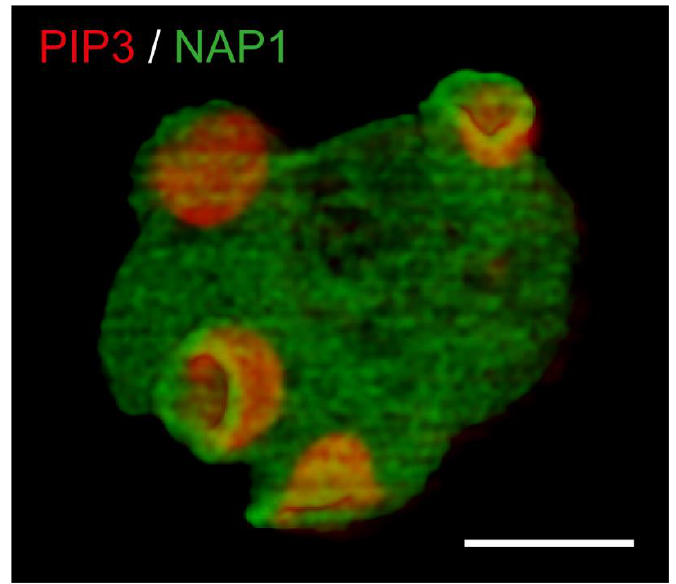
Figure 3. Macropinocytic cup formation in Dictyostelium. A 3D projection from a timelapse of Dictyostelium cells co-expressing a reporter for the signalling lipid PIP 3 (PH-pkgE-RFP) that designates the cup interior and is encircled by a ring of the SCAR/WAVE complex (shown by NAP1-GFP). Images taken by lattice light sheet microscopy. Bar = 10 μ M.